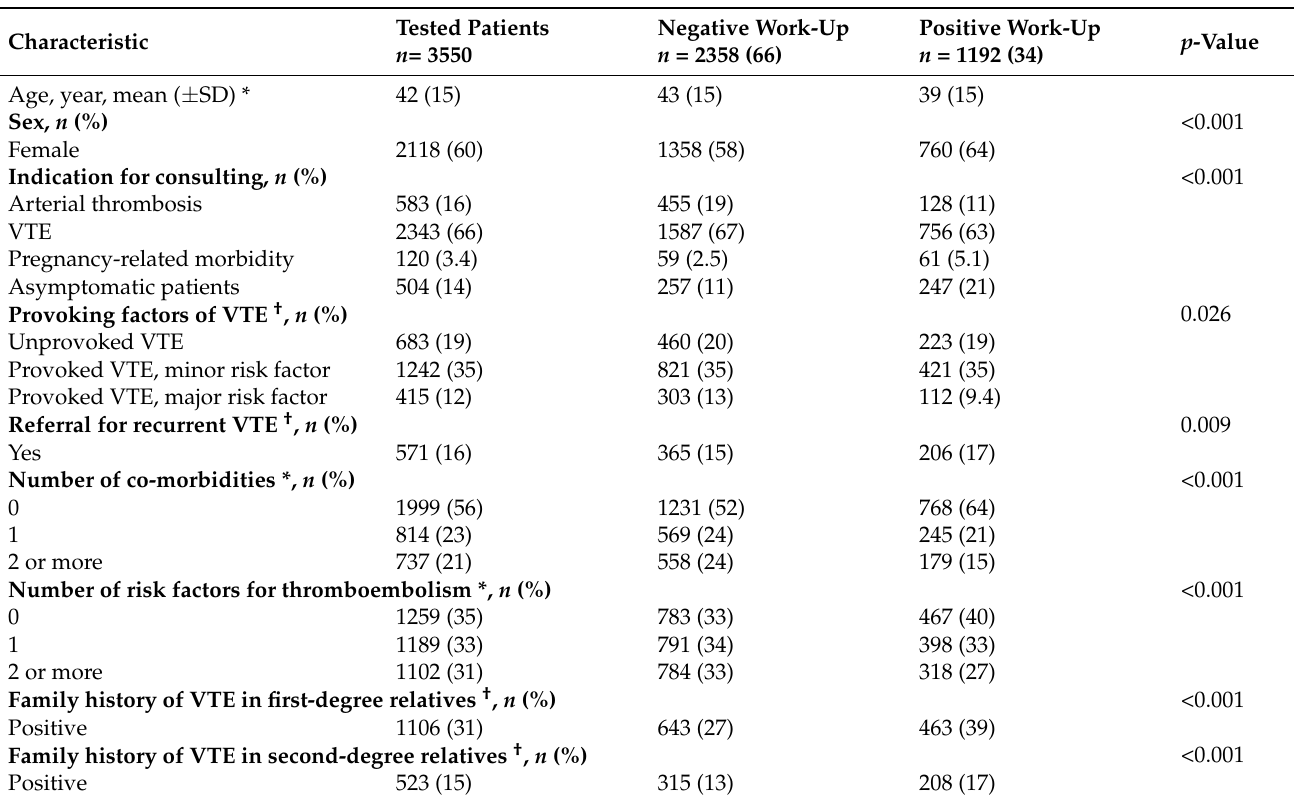
Table 2. Clinical characteristics of the patients included in the study in accordance with thrombophilia work-up